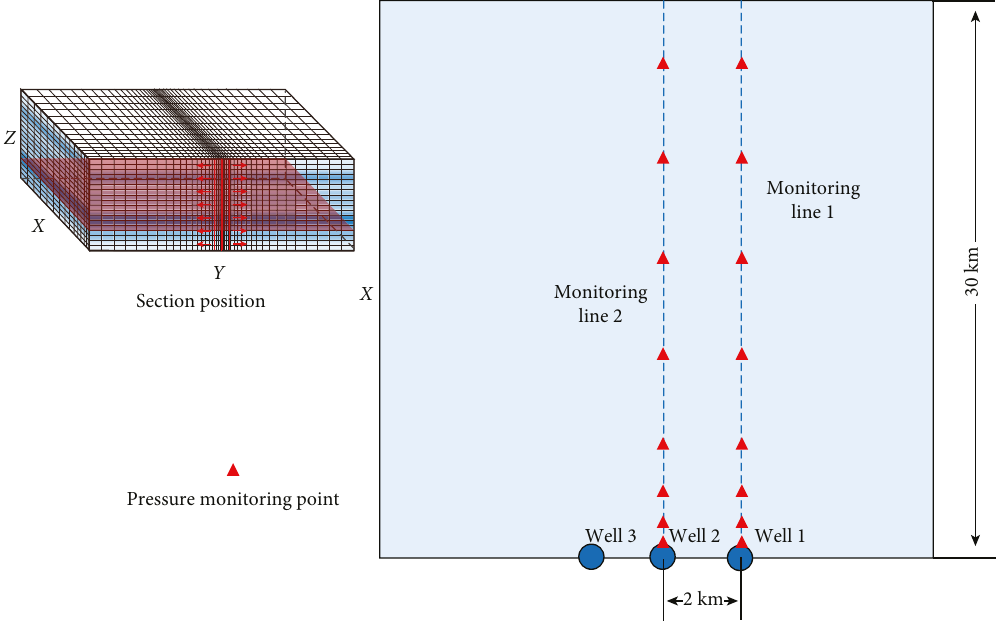
Figure 21: Positions of the pressure monitoring points in the 3-well